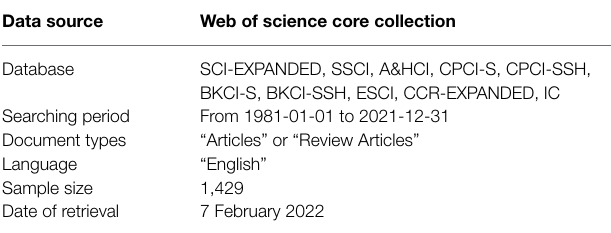
TABLE 1 | Summary of data collection and search